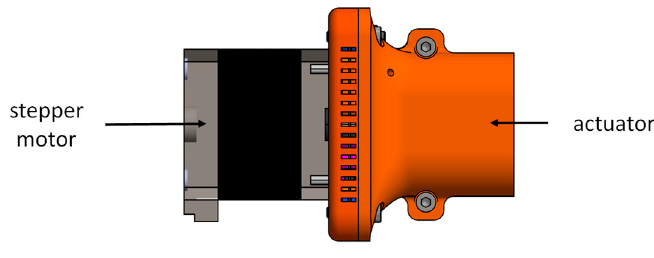
Figure 18. Actuator next to a stepper motor for size comparison.